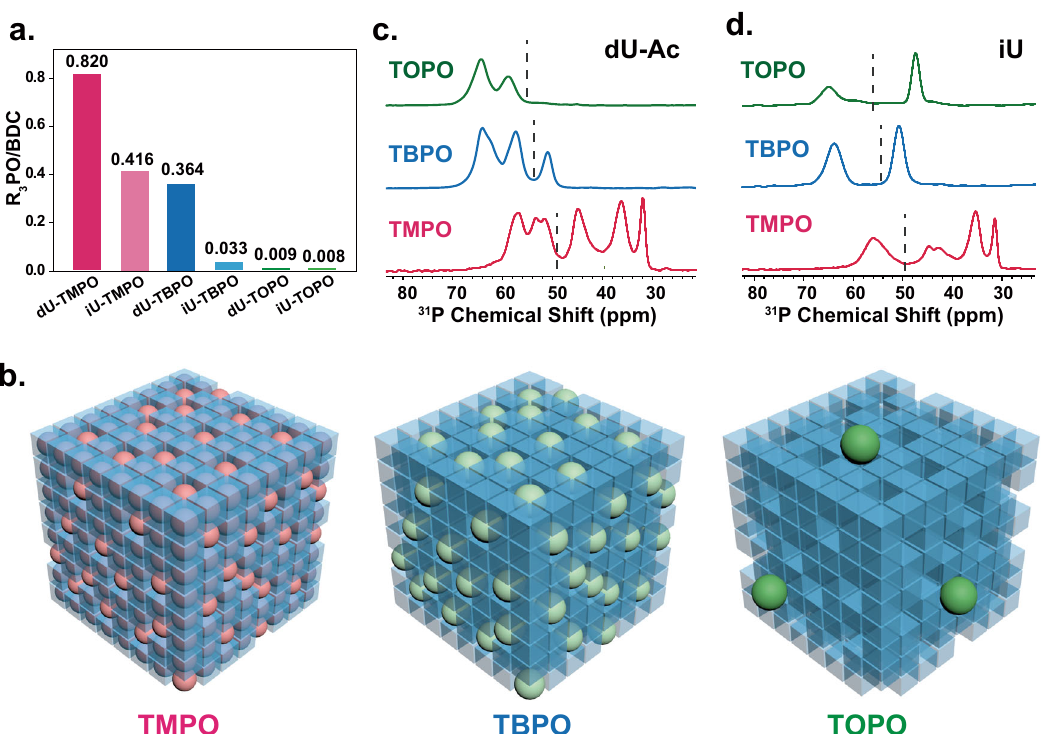
Fig. 4 | Accessibility of defects. a The molar concentrations of TMPO and its homologs loaded in UiO-66 as determined by 1 H dissolution NMR; b Schematic diagrams of the accessibility ofdifferent probe moleculesindefectiveUiO-66. The spheres represent the probe molecules, the colored cubes represent the cages of